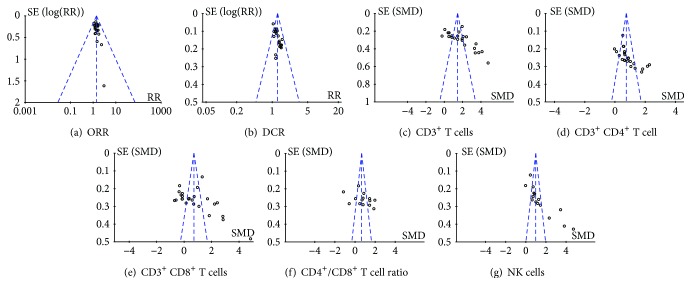
The analysis of publication bias.